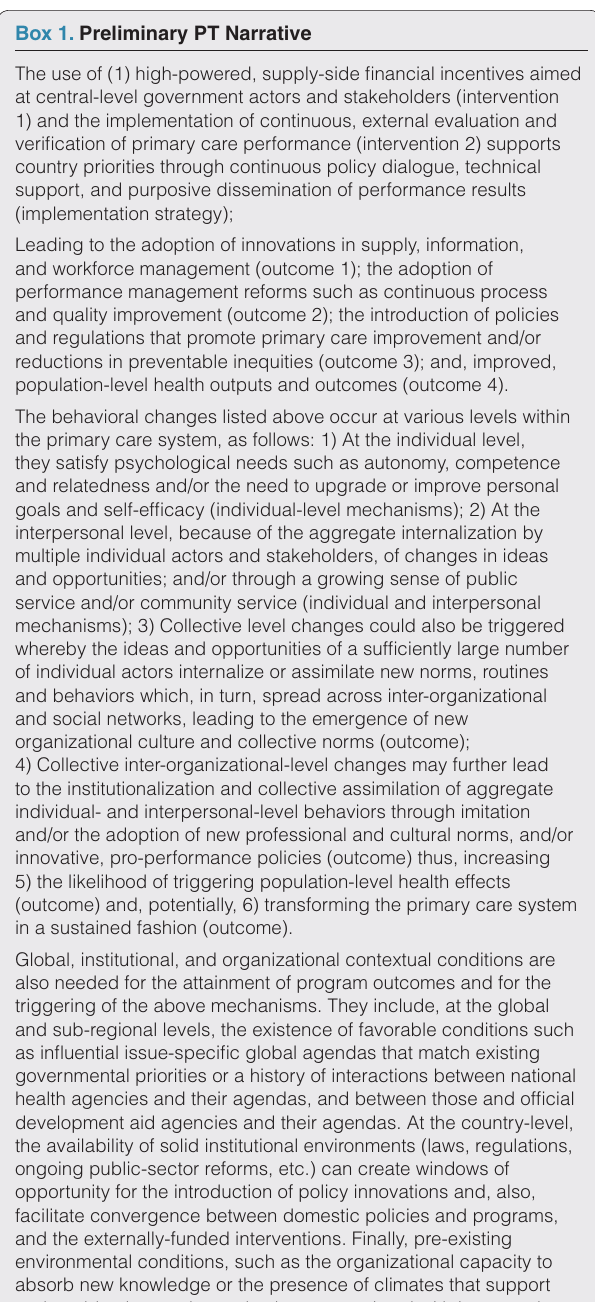
(Figure 2) to highlight the interrelated linkages between system elements and to avoid perceptions of linearity in causal